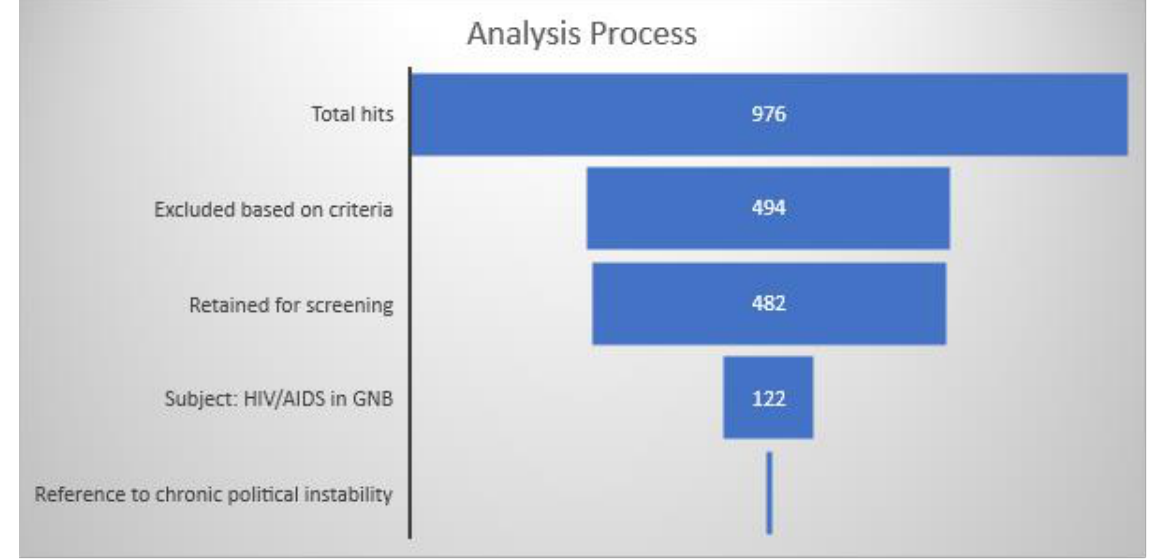
Figure 3. Results of analysis